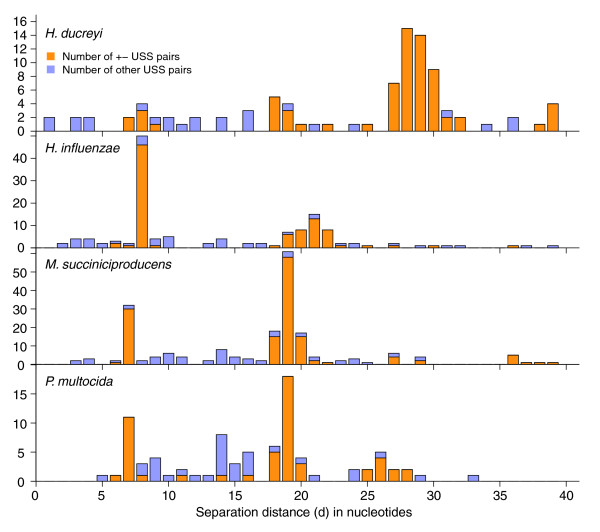
Bias toward +- configuration by separation distance. For each of four Pasteurellacaea, the height of the bar gives the total number of paired USS motifs separated by the given distance. The orange (lower) portion of the bar gives the number of pairs in the +- configuration. In H. influenzae, local peaks around approximately 8 and approximately 19-22 are due to the preservation of the extended USS motif. The distribution of distances is different for H. ducreyi, which has a peak of pairs (all in the +- configuration) at separations of 27 to 30, and the preference for the +- motif is not apparent until larger separation distances.